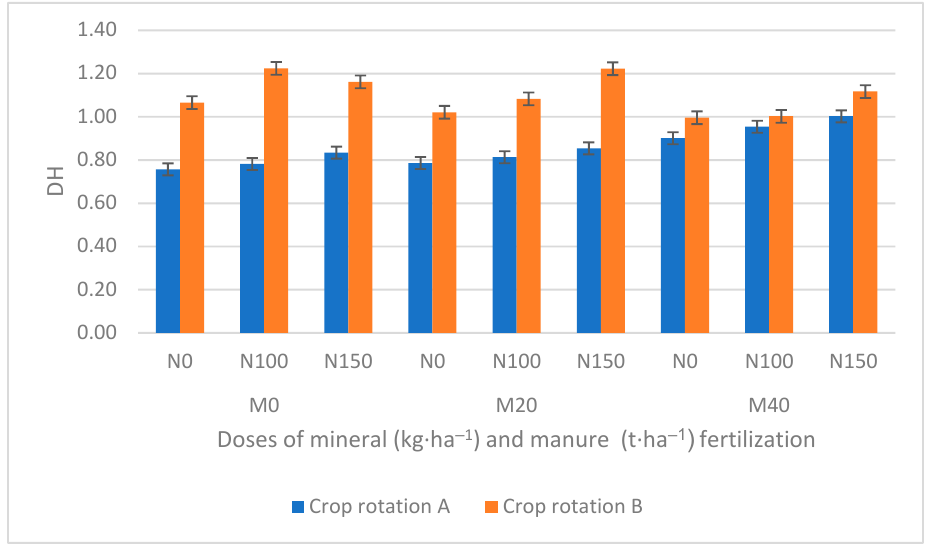
Figure 8. The degree of humification (DH) index as influenced by crop rotation, manure application and inorganic N rate in the long-term field experiment at Grabow, Poland. Error bars denote standard deviations ( n = 3). LSD ( p ≤ 0.05): for I = 0.021, II = 0.023, III = 0.015, II/I = 0.032, I/II = 0.033, III/I = 0.021, I/III = 0.026, III/II = 0.026, II/III = 0.031.